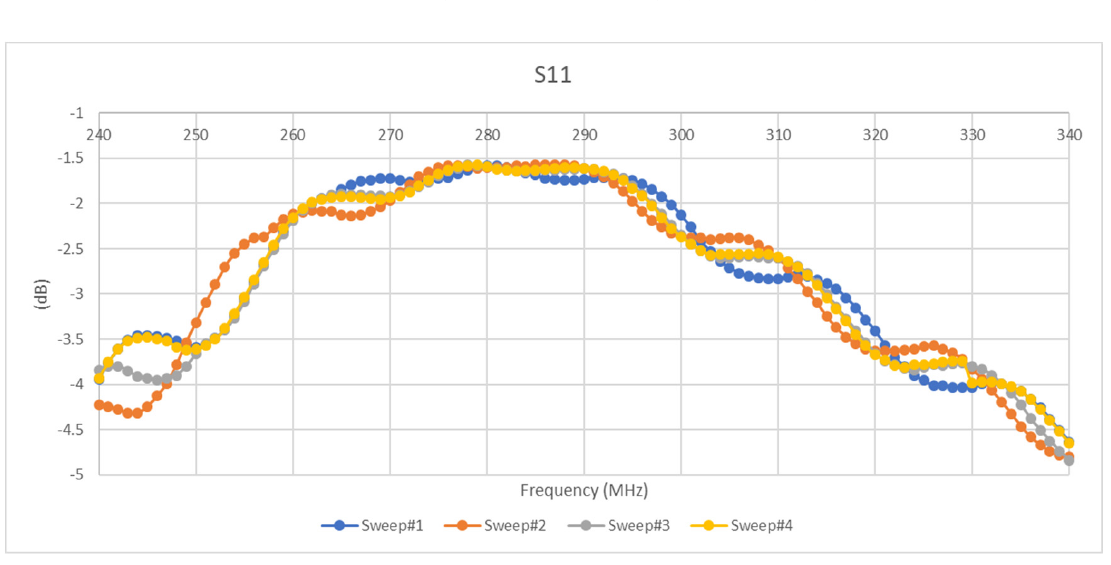
Figure 16. S21 results of sinusoidal excitation. Of most importance here is the distinction between this and the earlier ramped stimulus, the latter of which will not consist of multiple possible true minima in the S21 data as the resonant frequency of the tag cycles up and down the frequency range and coincides with the instantaneous measurement. This behavior poses an interesting question; at any point in the resulting data, which side of the resonant region is being observed? A diagram of the idealized resonant S21 response is given in Figure 13. In this figure, it can be seen that two possible frequencies correspond to the same S21 magnitude. Therefore, the direct use of this curve as a mapping function (continuous form) or lookup table (discrete form) requires further inferences in order for the result to be deemed valid. If the resonant bandstop S21 response is captured, it can be used to convert the measured magnitude at each frequency to the actual resonant frequency at that timestep in the sweep. There will of course be two curves generated using this lookup function as it cannot yet be discerned which parts of either curve is valid. For the subsequent analysis, a 41-point curve (20 points each side of the